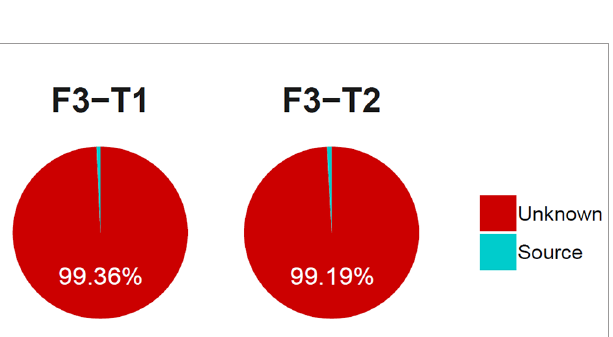
FIGURE 11 | The proportion of the tongue coating microbiota before and after sleep colonized in intestine. (T1 and T2 are the tongue coating microbiota before and after sleep respectively, F3 is the intestinal microbiota and the source suggests it is derived from the tongue coating